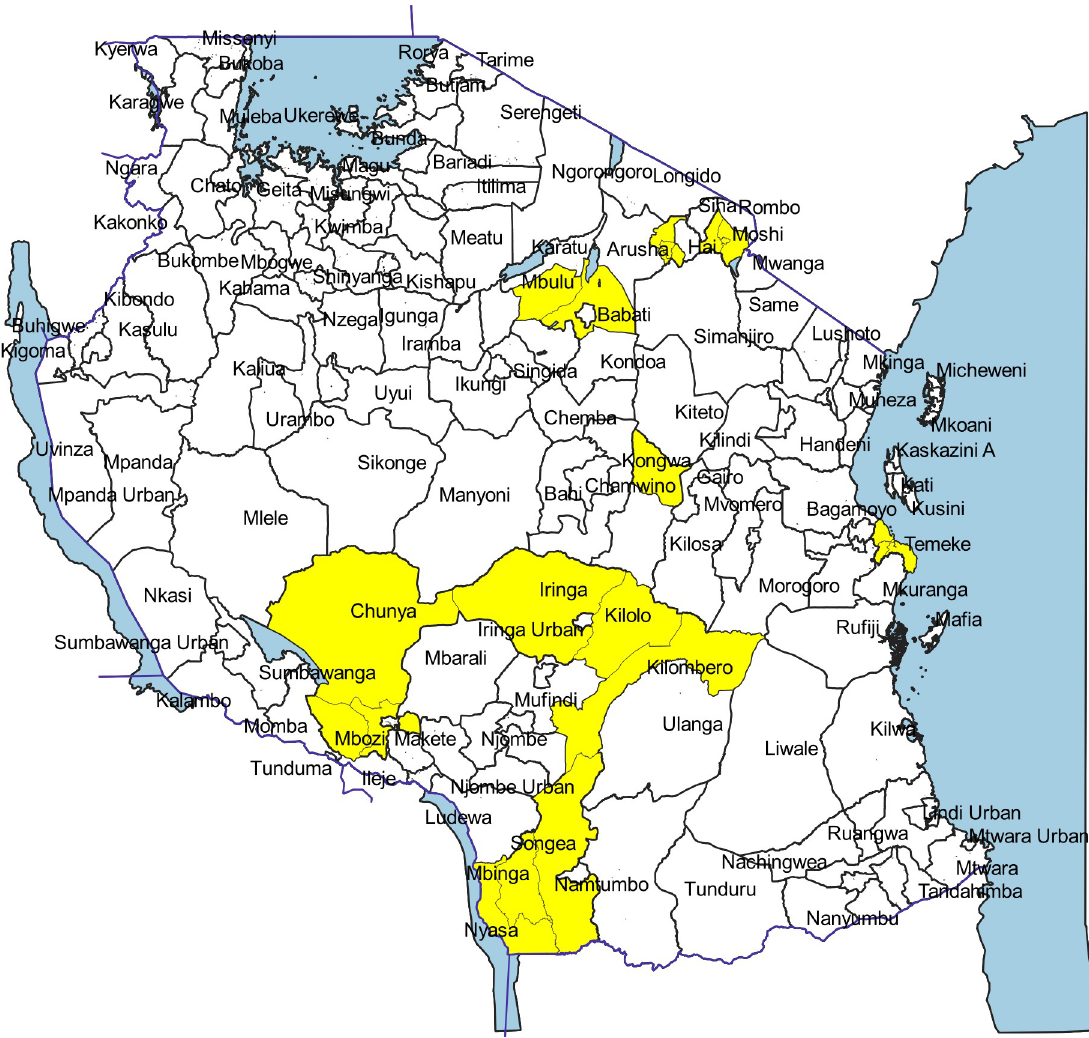
Fig 3. Locations (yellow) of previous studies for Taenia solium taeniosis/cysticercosis in Tanzania. 1995–2018.